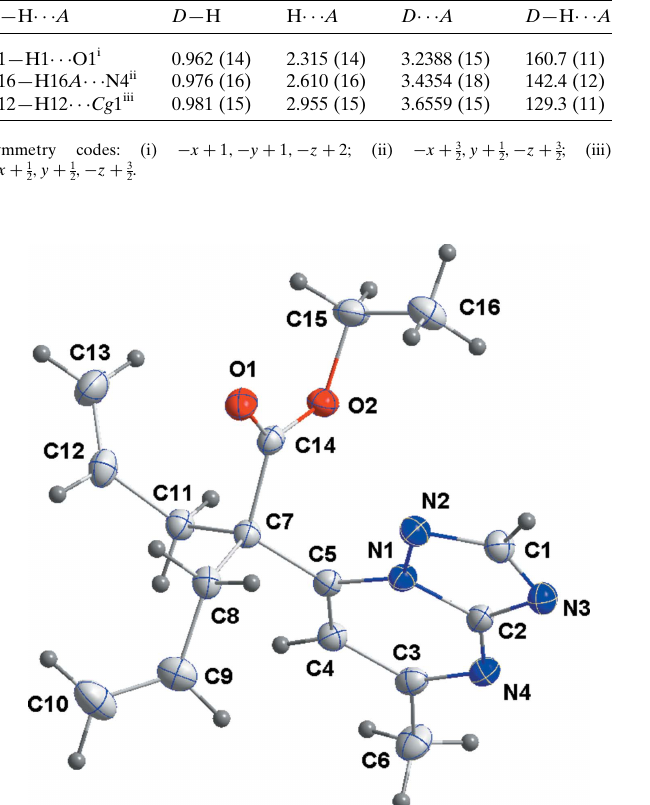
Figure 1 The title molecule, shown with 50% probability displacement